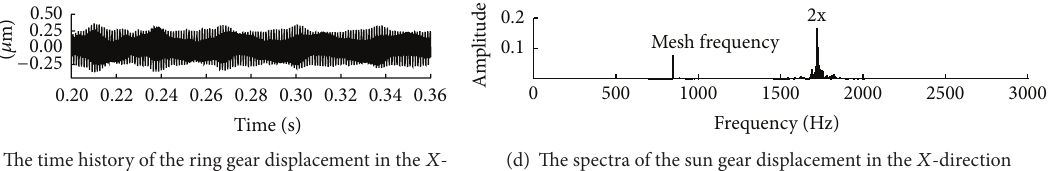
(d) The spectra of the sun gear displacement in the 𝑋 -direction